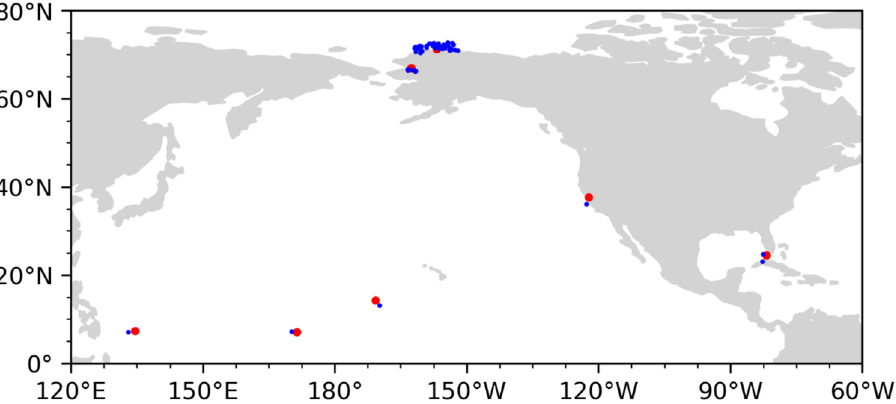
Figure 5. Spatial distributions of profiles collocated by COSMIC ROs and radiosonde data during 2007–2011 over the ocean (red dot indicates the radiosonde data, the blue dot indicates the RO data). The scatter plots of the PBLHs are obtained by statistical analysis of the COSMIC RO and radiosonde collocation dataset, as shown in Figure 6. The red dots indicate the data excluded for LSW > 30%, and the black dots are the final calculation results. The number of profiles after the fourth quality control step in Figure 6a,b are 50 and 51, respectively. those estimated by the potential temperature gradient approach of the radiosonde